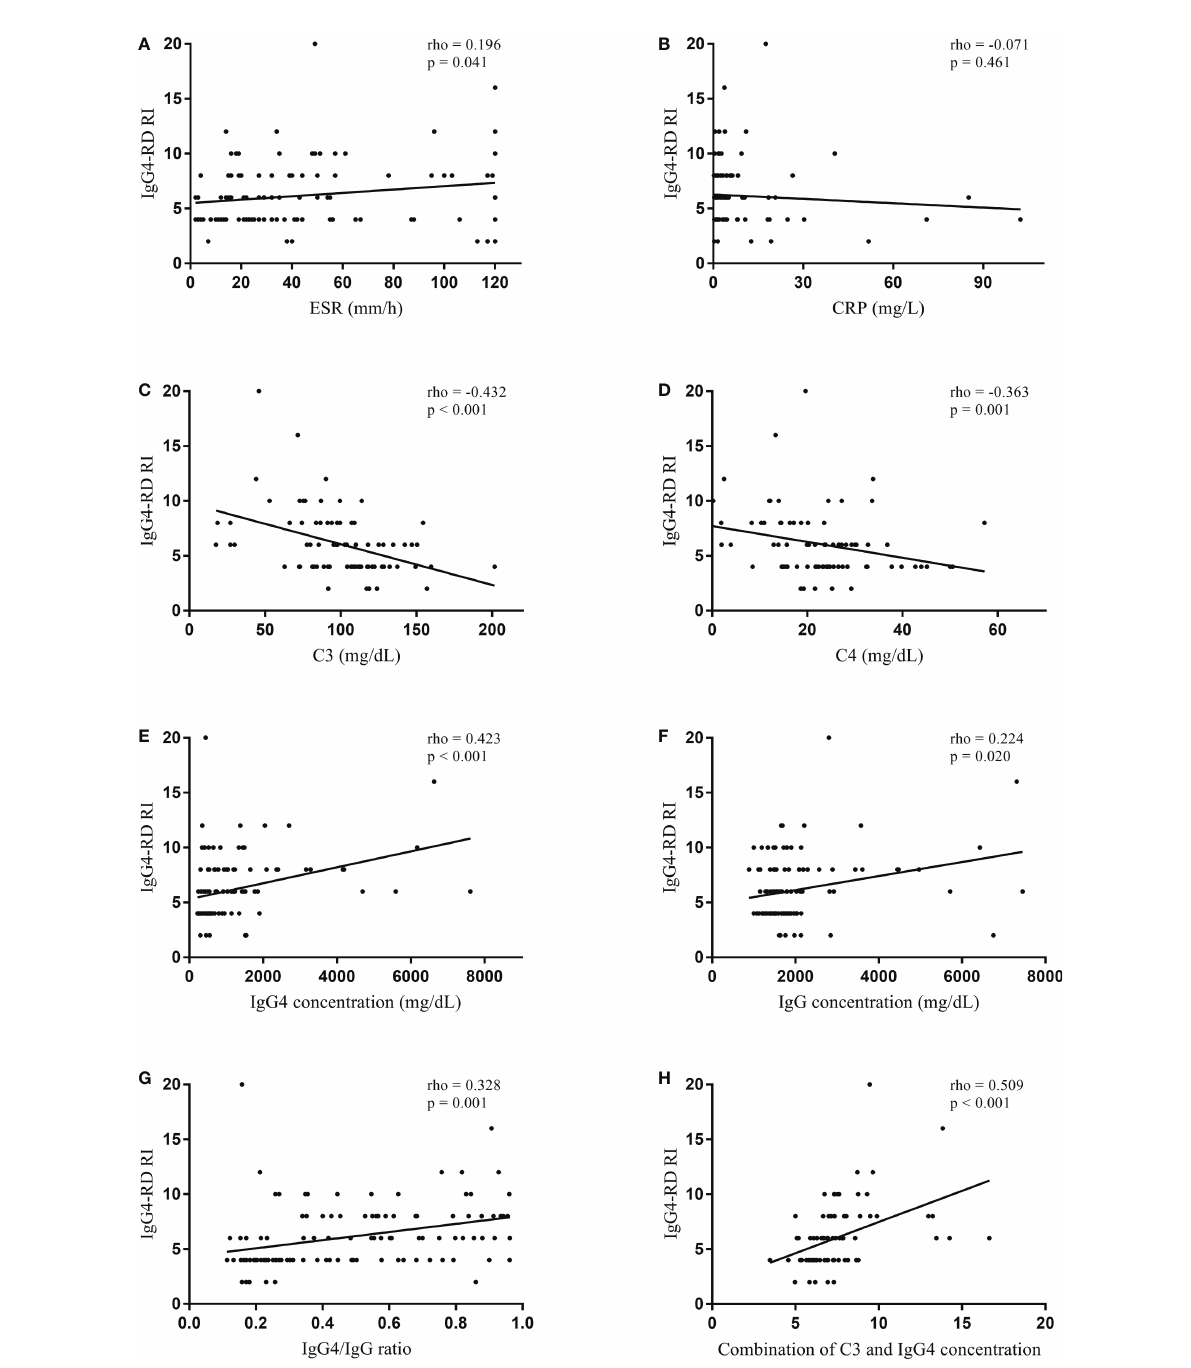
FIGURE 2 Spearman ’ s correlation coef fi cient between serologic parameters and IgG4-RD RI in the elevated serum IgG4 concentration group. (A) ESR, (B) CRP, (C) C3, (D) C4, (E) IgG4 concentration, (F) IgG concentration, (G) IgG4/IgG ratio, and (H) combination of C3 and IgG4 concentration (-0.034*C3 [mg/dL] + 0.001*IgG4 concentration [mg/dL]). IgG4-RD, IgG4-related disease; RI, responder index; ESR, erythrocyte sedimentation rate; CRP, C-reactive